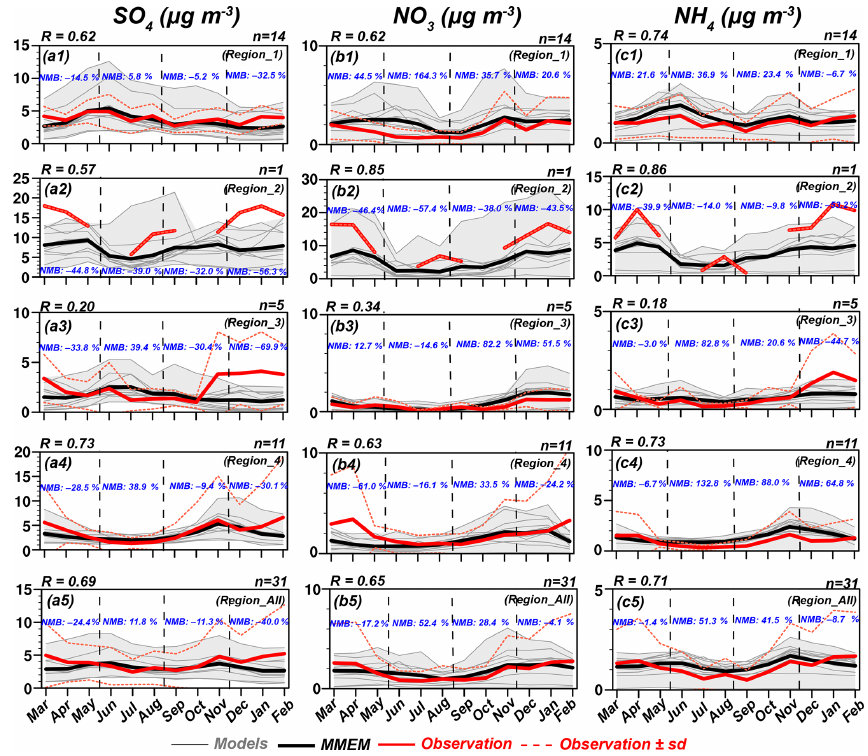
Figure 5. The same as Fig. 4 but for (a1–a5) SO 2 − from